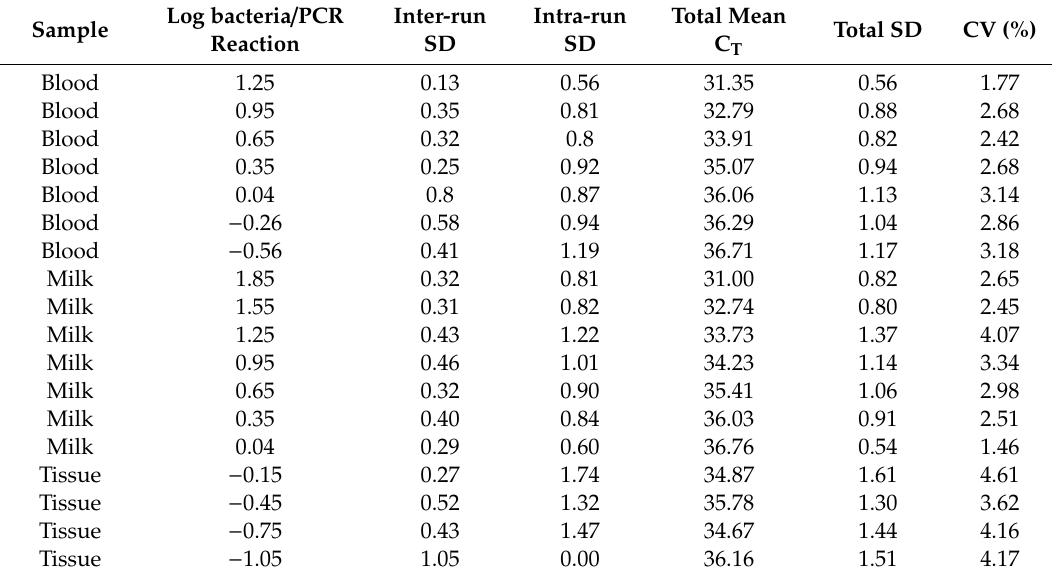
Table 5. Inter- and intra-assay reproducibility for the detection of Brucella spp., SD—standard deviation, C T —cycle threshold, CV—coe ffi cient of variation.